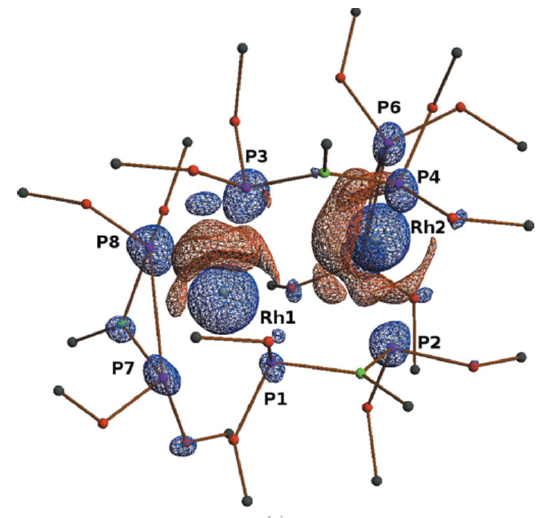
Figure 8. Photodifference map of the Rh 2 (µ-PNP) 2 (PNP) 22+ cation (red surfaces—positive values, blue—negative). Figure reproduced with permission of the International Union of Crystallography from Makal et al. [24].